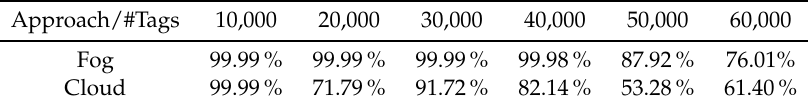
Table 4. Sample processing success rate under high loads.